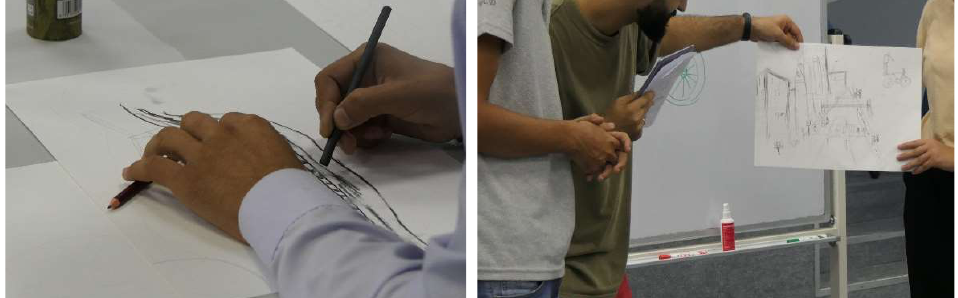
Figure 14. Inherent in the workshop methods of storytelling and drawing, are the acts of reflection, empathy, sharing, and engagement: a relaxed and joyful experience of participation with possible consequences for urban design improvements, and the reinforcement of Dushanbe’s cultural ecology (courtesy of Young Generation of